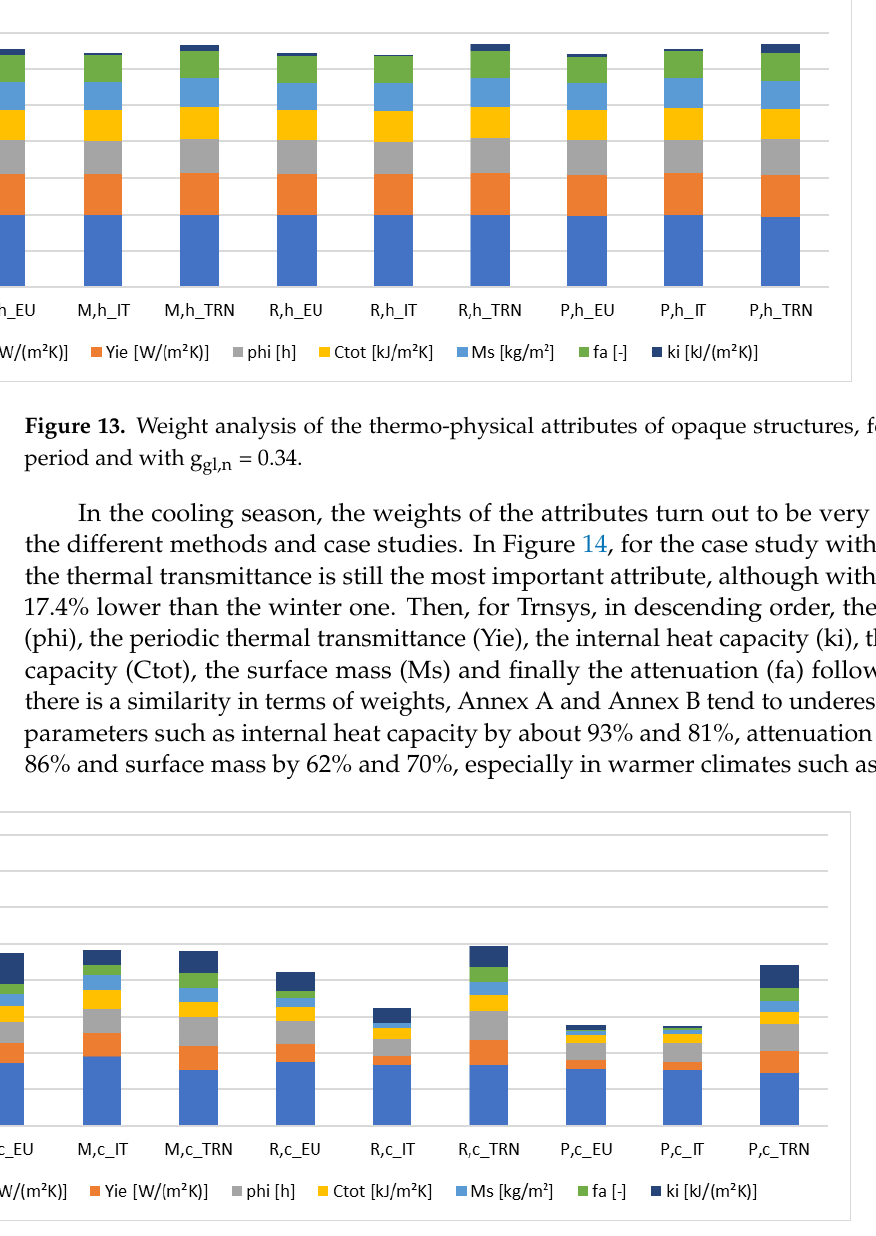
Figure 14. Weight analysis of the thermo-physical attributes of opaque structures, for the summer period and with g gl,n = 0.77.